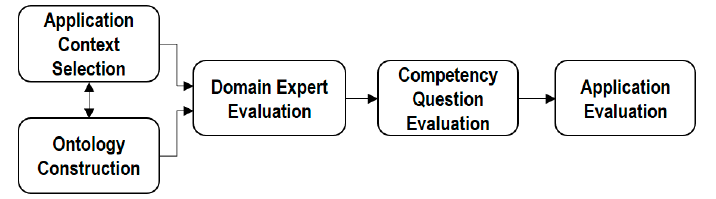
Figure 6. The ontology evaluation process.